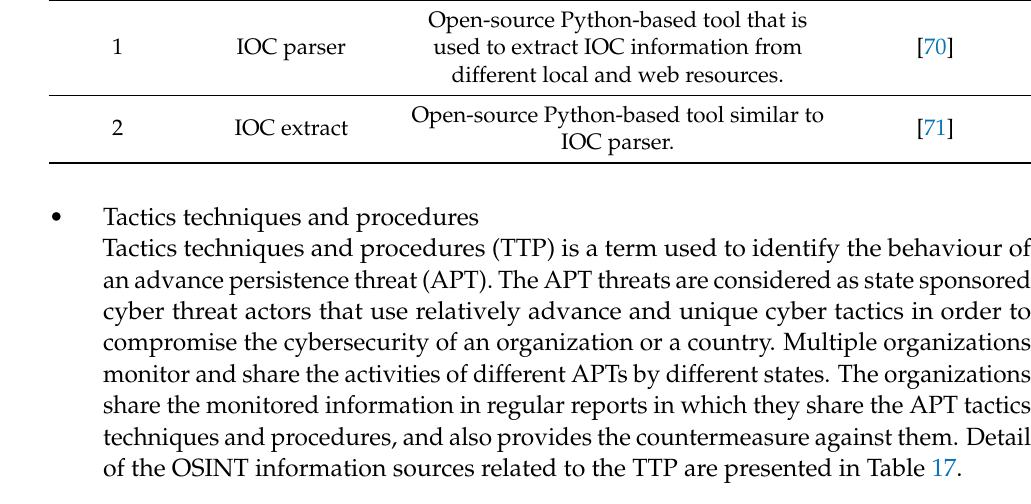
Table 17. Tools used for OSINT on adversary tactics techniques and